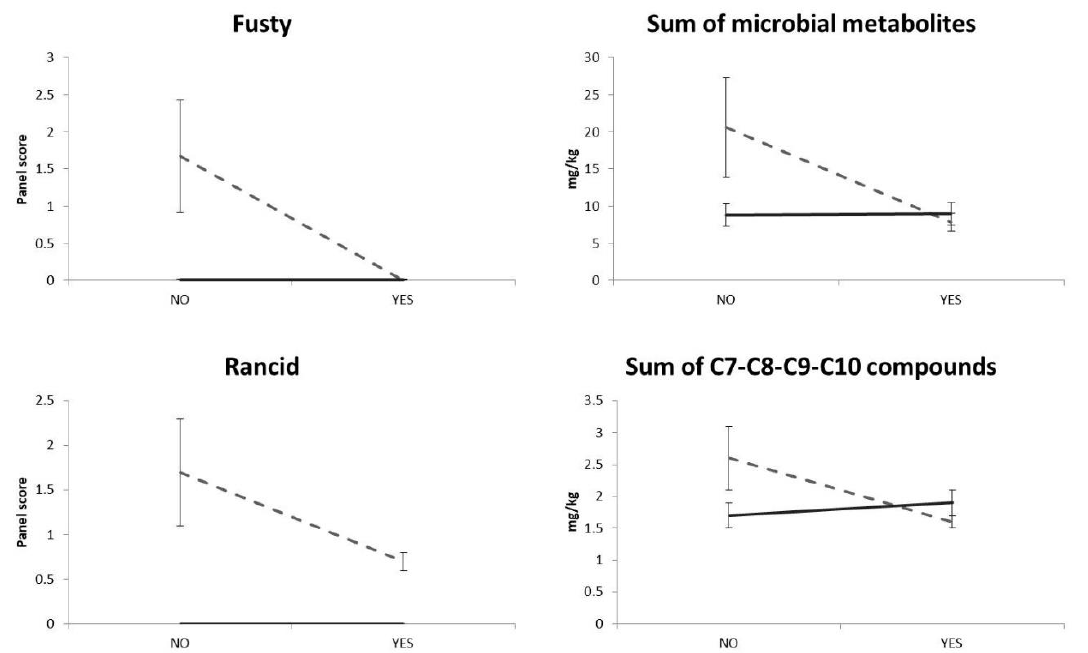
Figure 1. Interaction plots of “fusty” and “rancid” results given by the panel compared with chromatograph results (i.e., microorganism-related compounds for fustiness and C7-C8-C9-C10 compounds for rancidity). The x -axis reports HHP treatment (No or Yes). The continuous grey line shows filtered samples (i.e., filtration YES), and the black line cloudy samples (i.e., Filtration NO). Error bars represent the standard error.